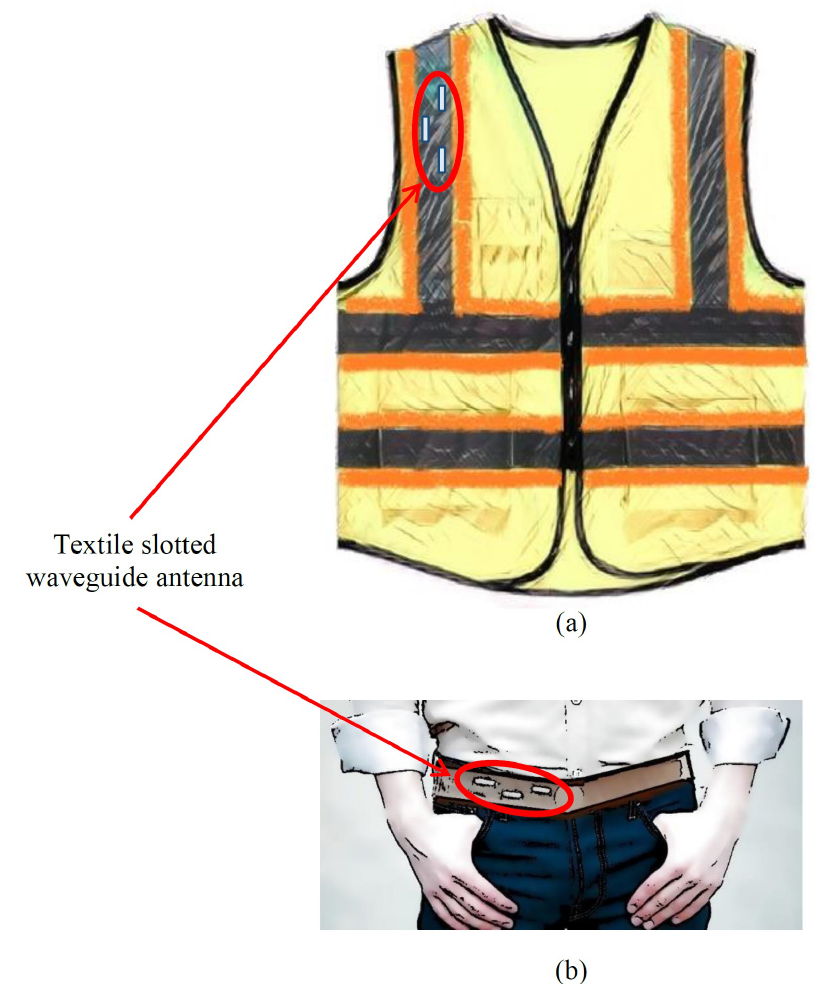
Figure 8. The textile antenna in use: ( a ) Smart safety vest, ( b ) smart belt.